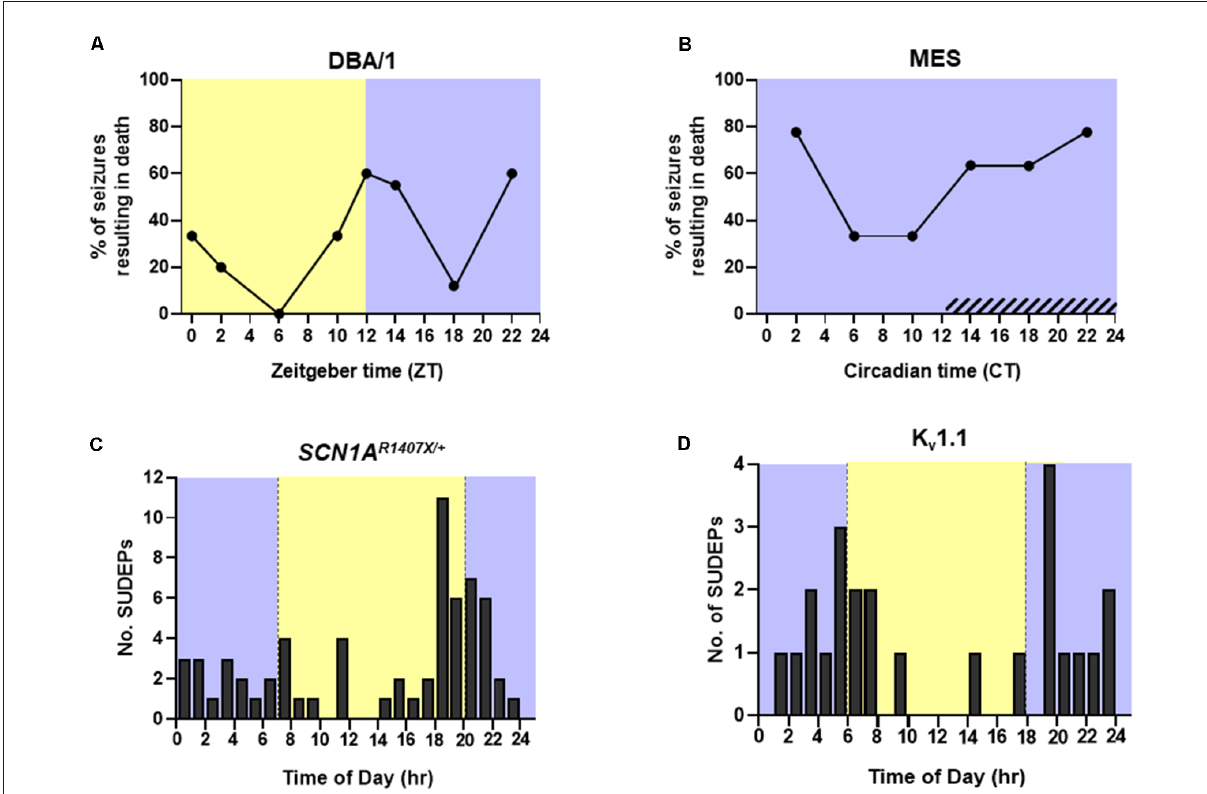
FIGURE4 Time-of-day and circadian probability of seizure-induced death in mouse models of epilepsy. Temporal distribution of spontaneous seizure- induced death in (C) SCN1A R1407X/+ and (D) Kv1.1 knockout mice housed in a 12:12 h light:dark cycle. (A) Percentage of audiogenic seizures resulting in death in DBA/1 mice housed in a 12:12 h light:dark cycle. (B) Percentage of maximal electroshock (MES) seizures resulting in death in mice housed in constant darkness. Redrawn with permission from (C) Teran et al. (2019), (D) Moore et al. (2014), (A,B) Purnell et al.